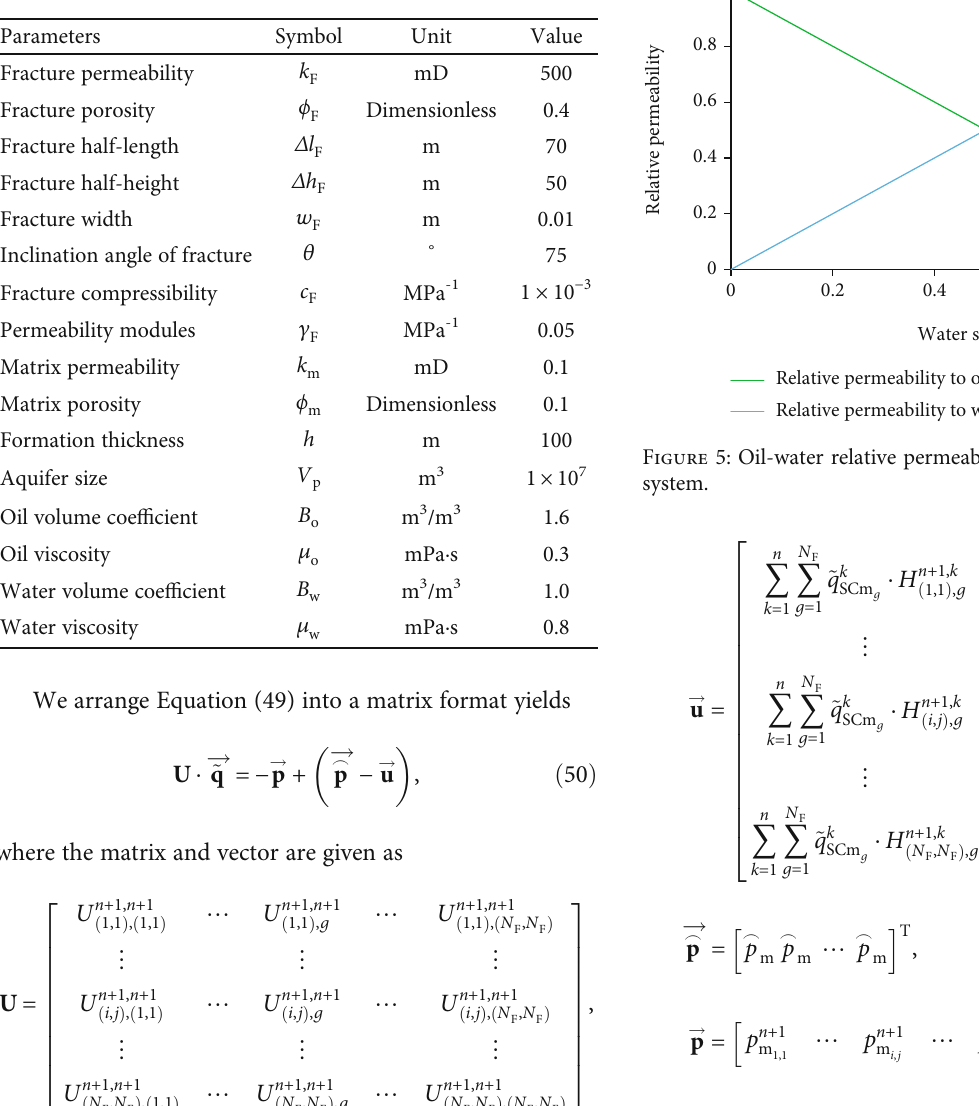
Figure 4: Schematic diagram of fracture distribution and discretizing for numerical Table 1: Parameters used for model validation.